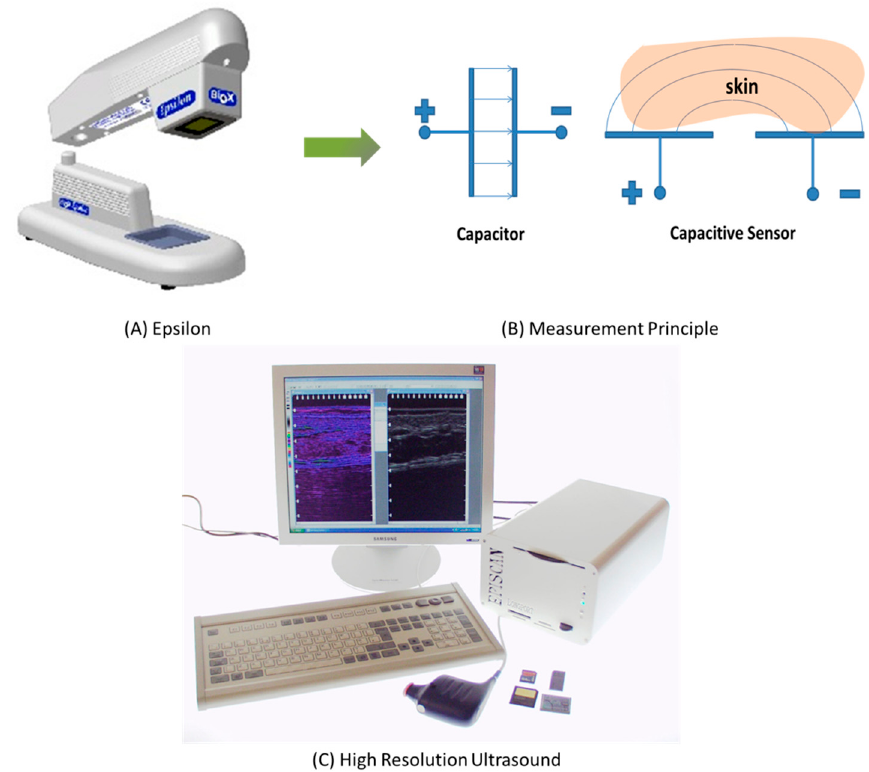
Figure 1. Epsilon permittivity imaging system ( A ), its measurement principle ( B ) and EPISCAN I-200 imaging system ( C ) [13].